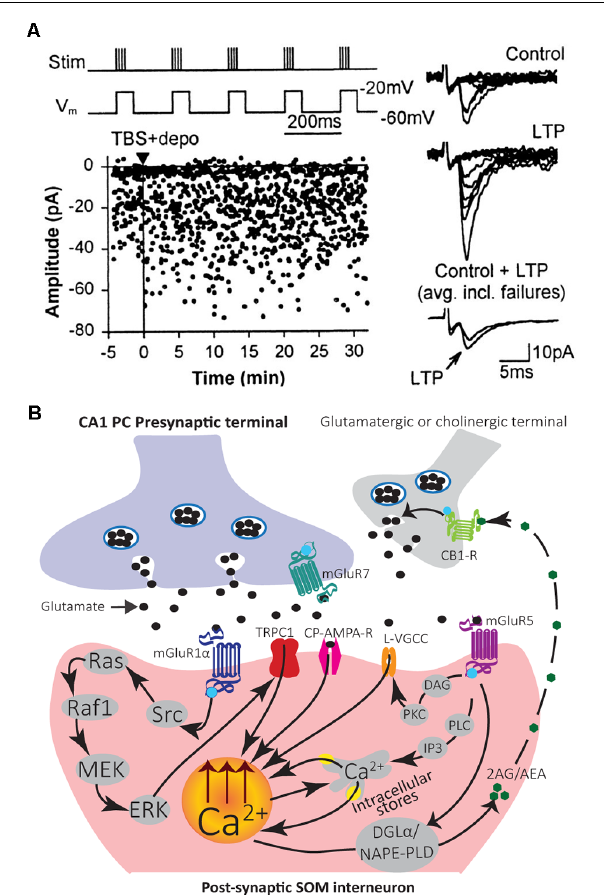
FIGURE 3 | Mechanisms of induction and modulation of Hebbian LTP in SOM interneurons. (A) Graph of EPSC amplitude from a representative cell showing LTP after TBS paired with depolarization (TBS + depo; protocol shown above and delivered at time indicated by black triangle and vertical line). Examples of control and potentiated EPSCs (10 consecutive responses) at 30 min after induction ( Right ). Superimposed average EPSCs (bottom traces; n = 64 responses each, failures included) from control and 30 min after induction also show LTP. Adapted from Perez et al. (2001). (B) Diagram of LTP induction mechanisms leading to postsynaptic Ca 2+ elevation in SOM interneurons. Stimulation of the presynaptic terminal releases glutamate that activates postsynaptic CP-AMPAR and mGluR1 α . Activation of mGluR1 α stimulates the Src signaling cascade leading to ERK activation. ERK leads to postsynaptic Ca 2+ rise via activation of non-selective cationic channels TRPC1 and Ca 2+ entry, as well as mobilization of Ca 2+ from intracellular stores. A retrograde signaling mechanism may involve eCBs. Synaptic activation of mGluR1/5 stimulates synthesizing enzymes DGL α and/or NAPE-PLD to produce the eCBs 2-AG and/or AEA. 2-AG/AEA act retrogradely to activate CB1Rs on glutamatergic or cholinergic terminals and potentiate transmission. A potential mechanism of LTP modulation may involve activation of mGluR5 that produces postsynaptic Ca 2+ rises via